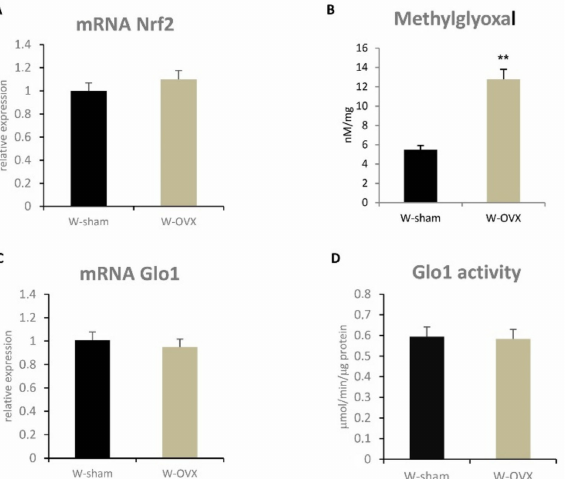
Figure 5. Hepatic parameters of oxidative and dicarbonyl stress: relative mRNA expression of NRF2 ( A ), methylglyoxal concentration ( B ), mRNA expression and activity of Glo1 ( C , D ) in ovariectomized Wistar female rats compared to sham-operated controls. Nrf2—nuclear factor-erythroid 2-related factor-2, Glo1—glyoxalase-1. Significance was determined using the unpaired Student’s t test (** denotes p <